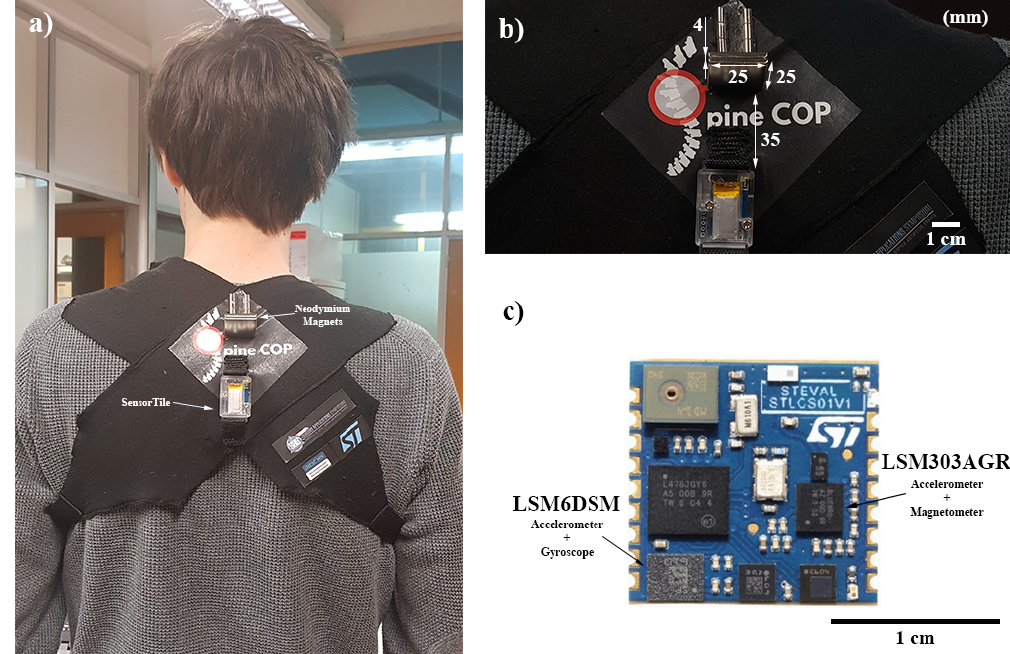
Figure 1. ( a ) User wearing the SpineCop wearable device. ( b ) Detailed view of the SpineCop device.